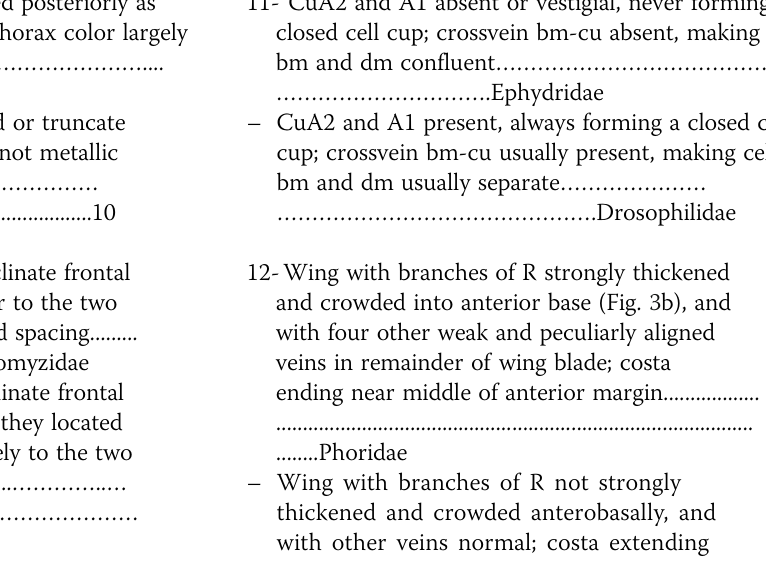
11- CuA2 and A1 absent or vestigial, never forming a closed cell cup; crossvein bm-cu absent, making cells – CuA2 and A1 present, always forming a closed cell cup; crossvein bm-cu usually present, making cells .Drosophilidae 12-Wing with branches of R strongly thickened and crowded into anterior base (Fig. 3b), and with four other weak and peculiarly aligned veins in remainder of wing blade; costa thickened and crowded anterobasally, and with other veins normal; costa extending